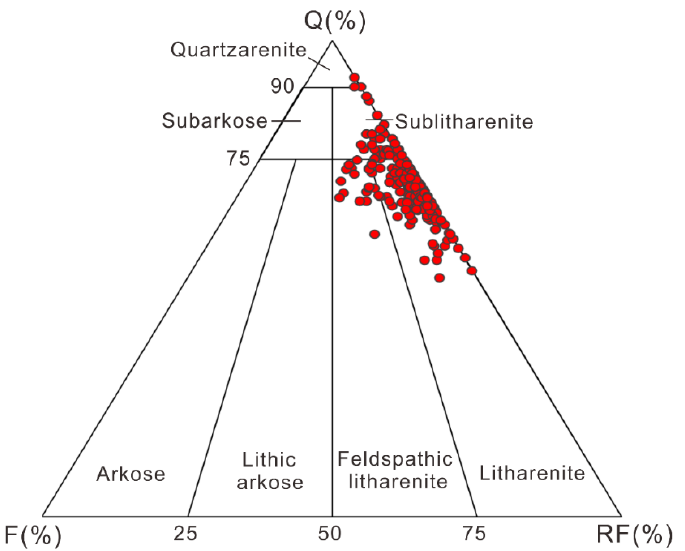
Figure 4. Composition diagram of the sandstone reservoirs in the Lower Shihezi Fm. in the Hangjinqi area, Q: quartz; F: feldspar; RF: rock fragment. (Number of samples = 250).